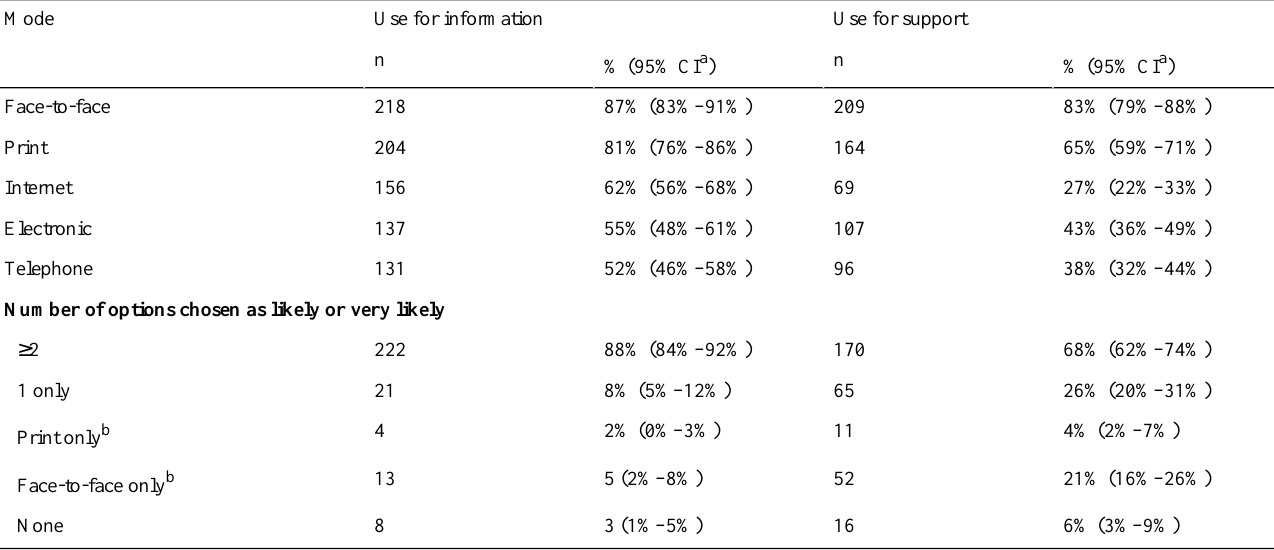
Table 3. Likelihood (likely/very likely) of using Internet, telephone, print, electronic media, or face-to-face forms of support (n = 251)